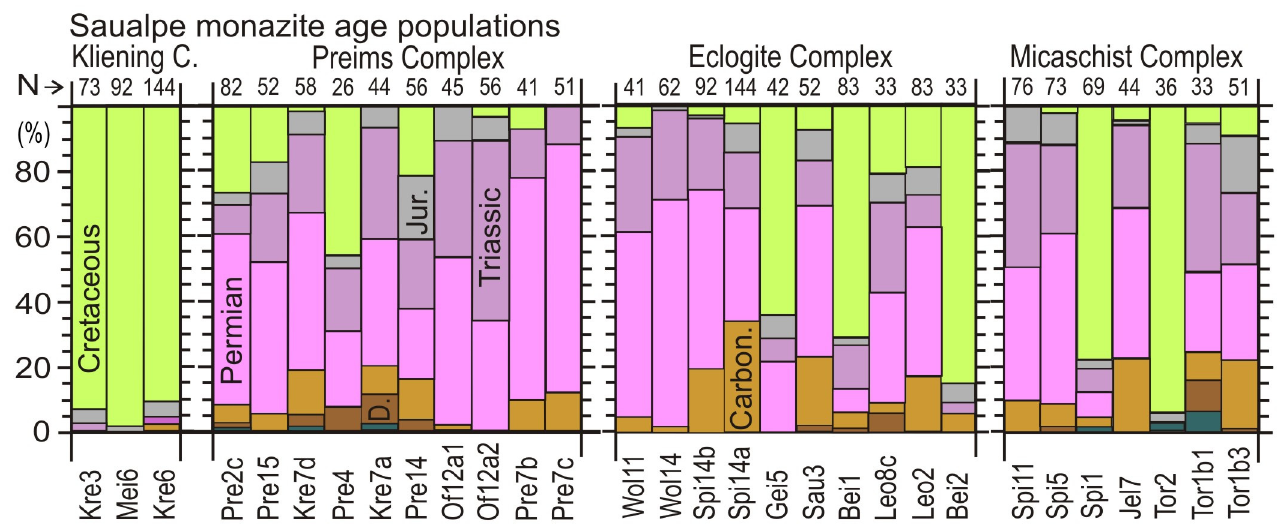
Figure 8. Kliening, Preims, Eclogite and Micaschist complexes in the Saualpe with diverse distribution of Silurian (blue- green), Devonian (D.), Carboniferous (Carb.), Permian, Triassic, Jurassic (Jur, in grey) and Cretaceous (140–60 Ma, in green) monazite ages recalculated to %, in single samples, partly compiled from data in [27,29].